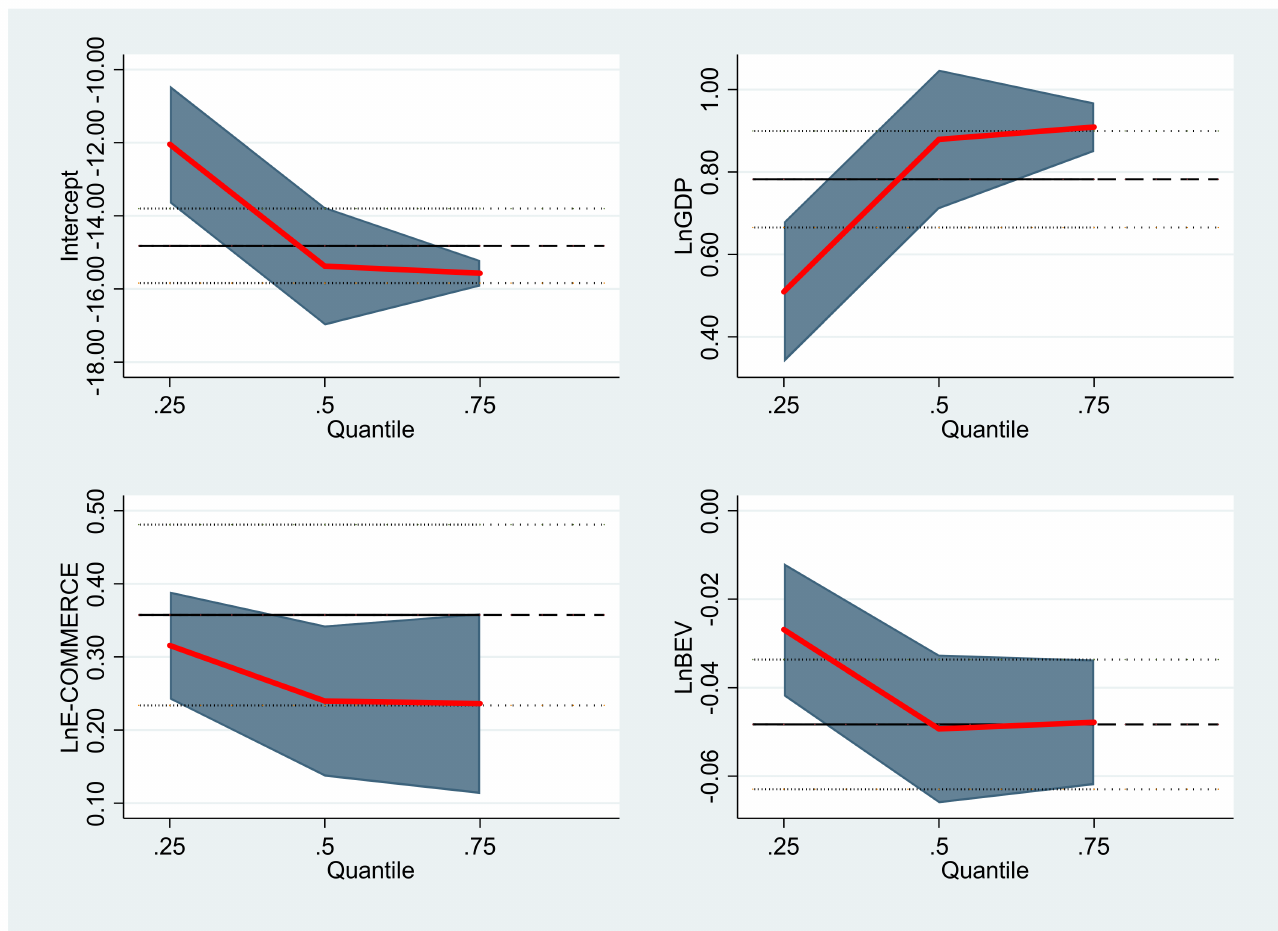
Figure 3. Quantile estimate: Shaded areas are (95%) confidence bands for the quantile regression